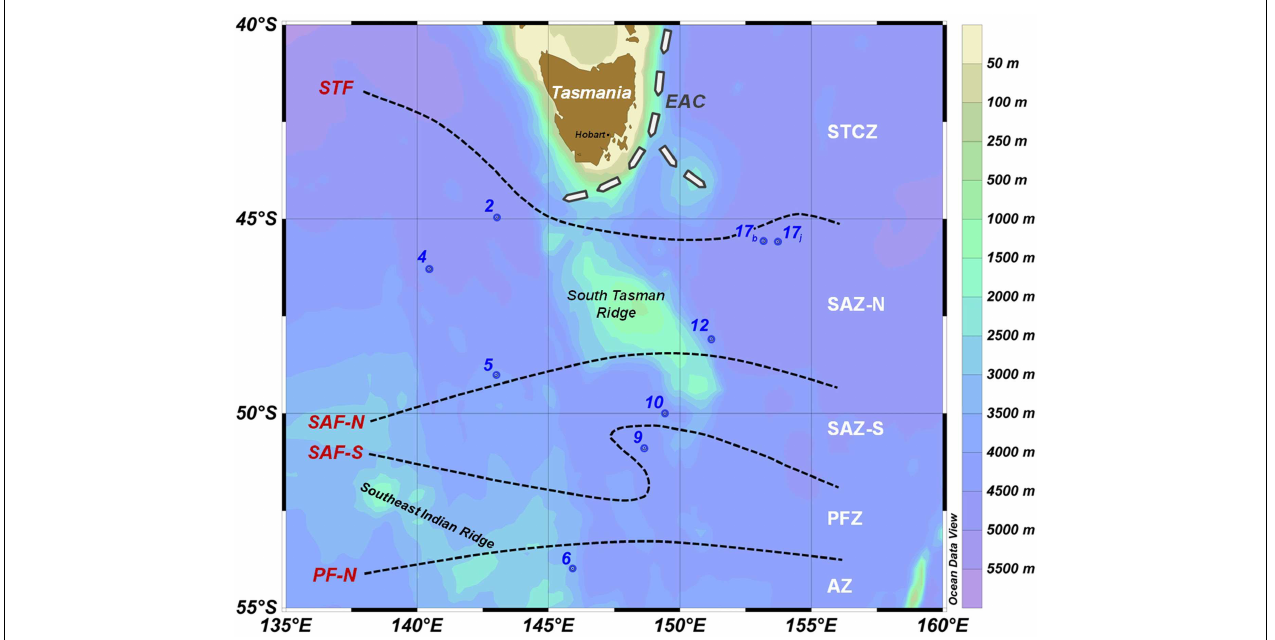
Tasmania is theTasman Outflow (Ridgway, 2007). Fronts (red text on left): STF, Subtropical Front; SAF-N, Subantarctic Front–North; SAF-S, Subantarctic Front–South; PF-N, Polar Front–North. Zones between fronts (white text on right): STCZ, Subtropical Convergence Zone; SAZ-N, Subantarctic Zone–North; SAZ-S, Subantarctic Zone–South; PFZ, Polar Frontal Zone; AZ, Antarctic Zone. Station 17 was sampled twice (on cast b and j on the 11 February 2007 and 17 February 2007,